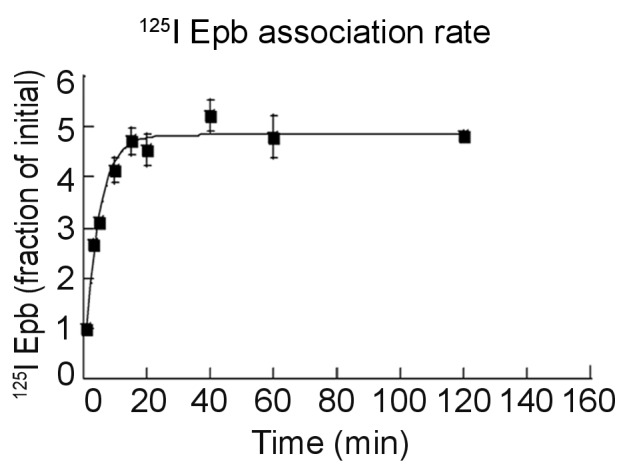
Association rate of 125I-epibatidine.Live cells were bound with 0.1 nM 125I-epibatidine at room temperature for the indicated times. The line through the points represents a least-squares fit to the normalized 125I-epibatidine uptake for the α4β2R-expressing HEK cells plotted as the fraction [125I-Epb]up(t) / [125I-Epb]up(0) and fit by the equation [125I-Epb]up(∞) / [125I-Epb]up(0)(1 - (exp(-kt))+1, where [125I-Epb]up(t) is the 125I-epibatidine uptake at time t, [125I-Epb]up(0) at time 0, [125I-Epb]up(∞) at saturation and k the association rate. Three independent experiments were performed on separate days and cultures. For all the points in the plot, error bars represent mean ± s.e.m from three independent experiments.